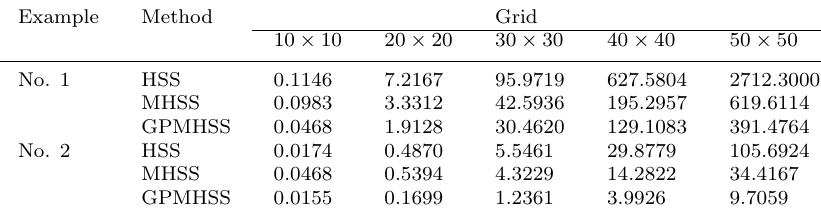
Table 4. The comparison of CPU time (measured in